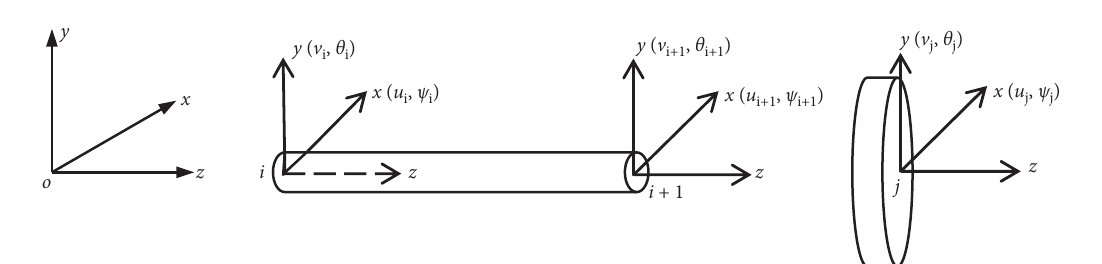
Figure 3: Schematic diagram of the coordinate system of the shaft